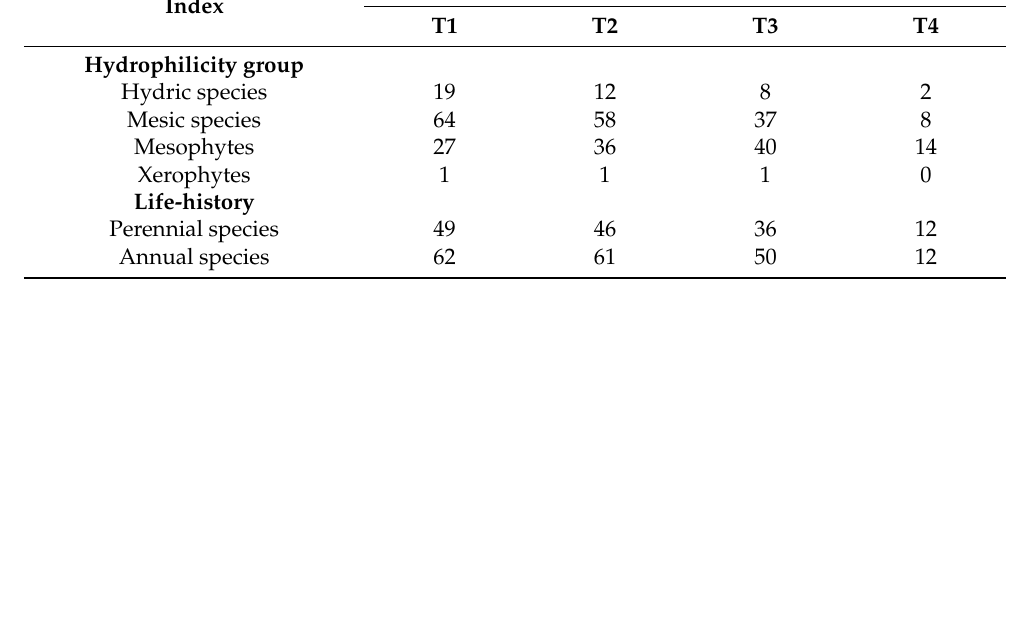
Figure 3. Plant life history types for four transects in each sampling site in the MLHR. P, perennials; A, annuals. T1, 2, 3, and 4 represent the first, second, third, and fourth transect, respectively. YPT, Yangpitan; LHH, Lihuahu; JJZ, Jiangjiazhou; NH, Nanhu; HJZ, Hujiazhou; SBC, Shanbiancun; WMD, Wumingdao; OM, Oumiao; YC, Yicheng; ZX, Zhongxiang; SPZ, Shipaizhen; ZK, Zekou; YK, Yuekou; GYT, Guanyintang. Table 1. Plant hydrophilicity and life history characteristics of the four transects in the MLHR, China.